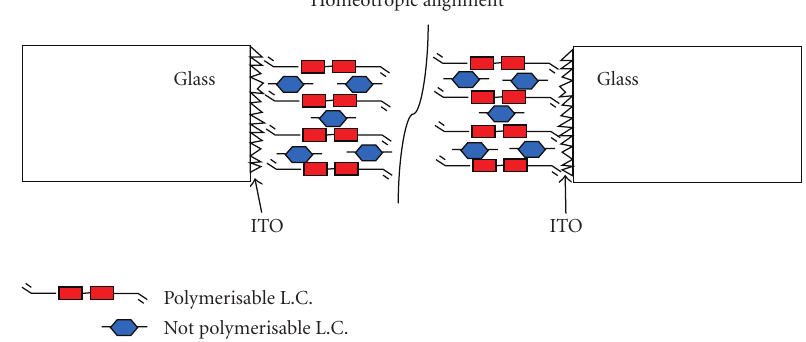
Figure 8: Possible device architecture for an ideal D/A organic solar cell.